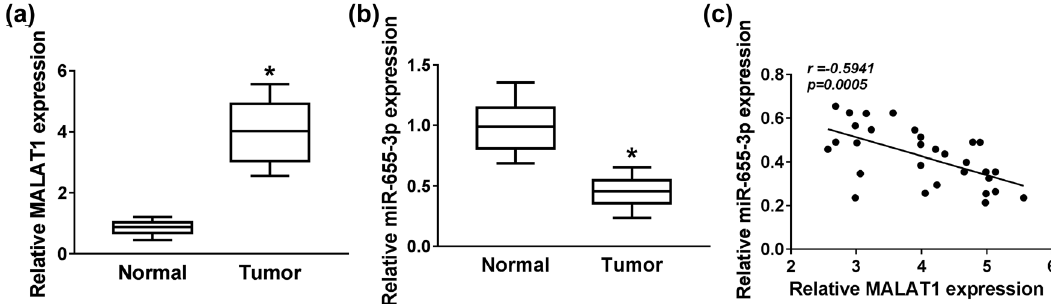
Figure 1: MALAT1 was upregulated, while miR - 655 - 3p was downregulated in RB tumor tissues. ( a and b ) The expression of MALAT1 and miR - 655 - 3p in RB tumor tissues and normal globe tissues were tested by RT - qPCR. ( c ) The correlation between miR - 655 - 3p and MALAT1 was veri fi ed by Pearson ’ s correlation analysis. * P <